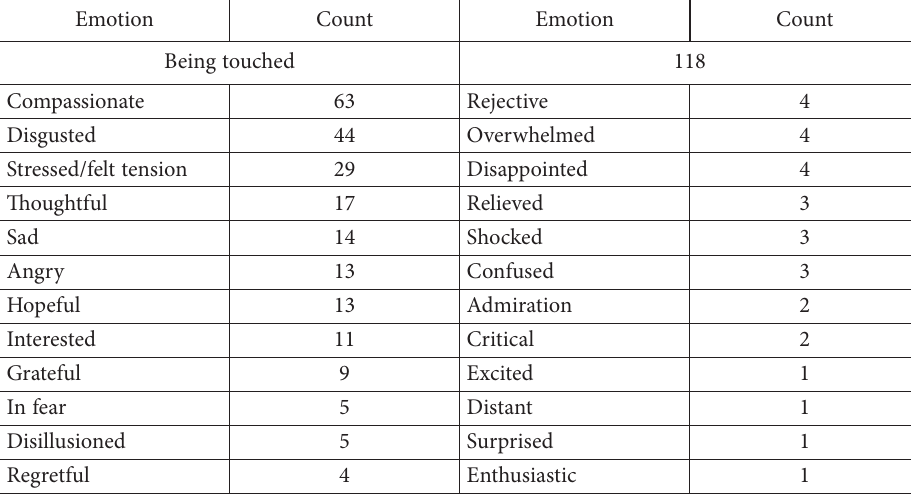
Table 1. Frequency count of emotions recognized in the TripAdvisor comments posted by visitors of the Committee State Security Building in Riga (source: created by